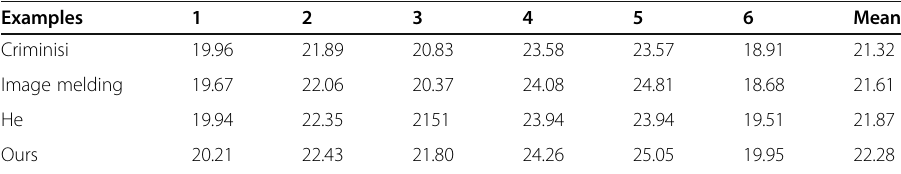
Table 1 Image completion performance measured in